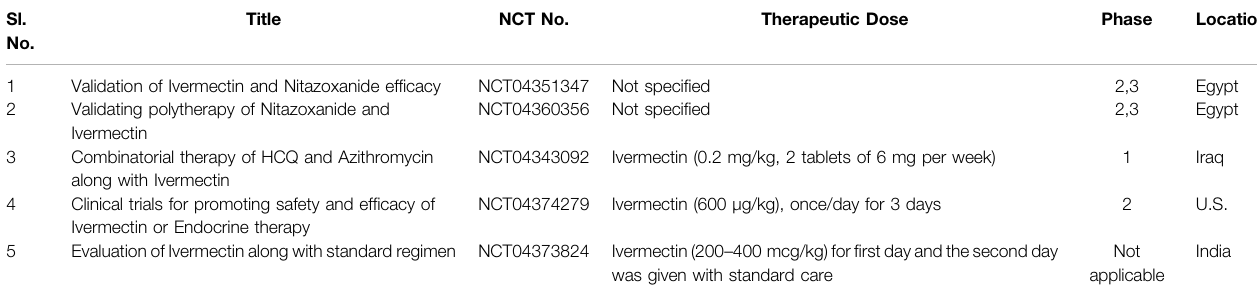
TABLE 6 | Running clinical trials for validation of Ivermectin (https://clinicaltrials.gov/ct2/results). Sl.